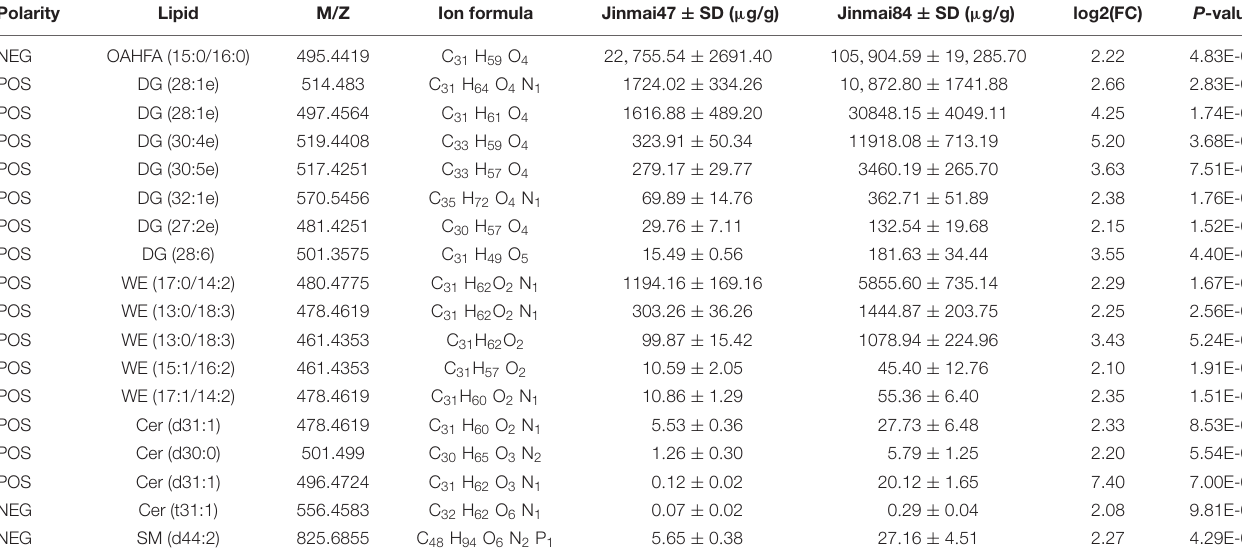
TABLE 2 | Lipid molecules showing significant differences between in two wheat varieties ( P -value < 0.05, log 2 (FC) > 2). Polarity Lipid M/Z Ion formula Jinmai47 ± SD ( µ g/g) Jinmai84 ± SD ( µ g/g) log2(FC) P